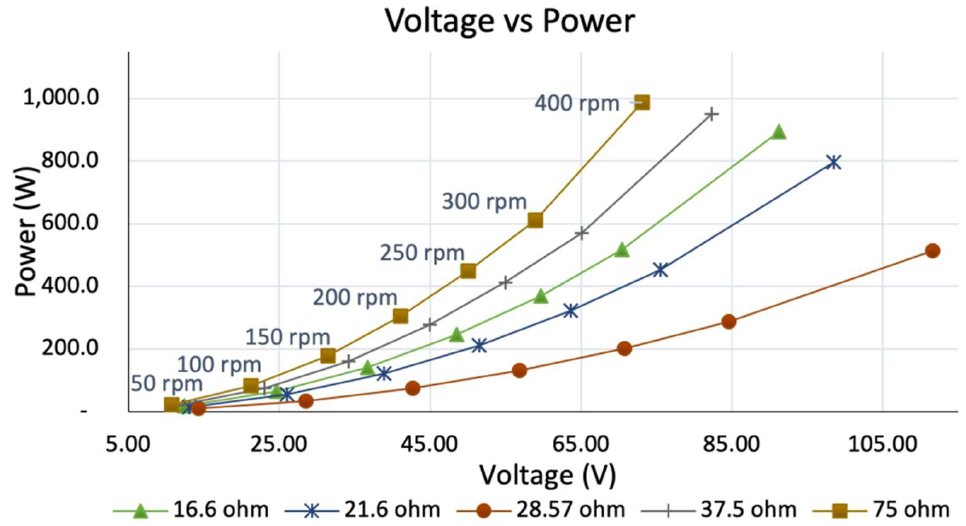
Figure 9. Simulation results under load conditions.